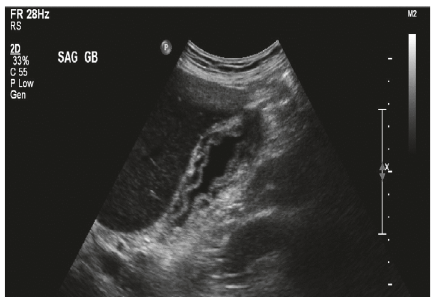
Figure 3: Grayscale longitudinal sonographic image of the right upper quadrant shows a decompressed gallbladder wall with diffuse wall thickening. The gallbladder wall has a striated appearance without increased